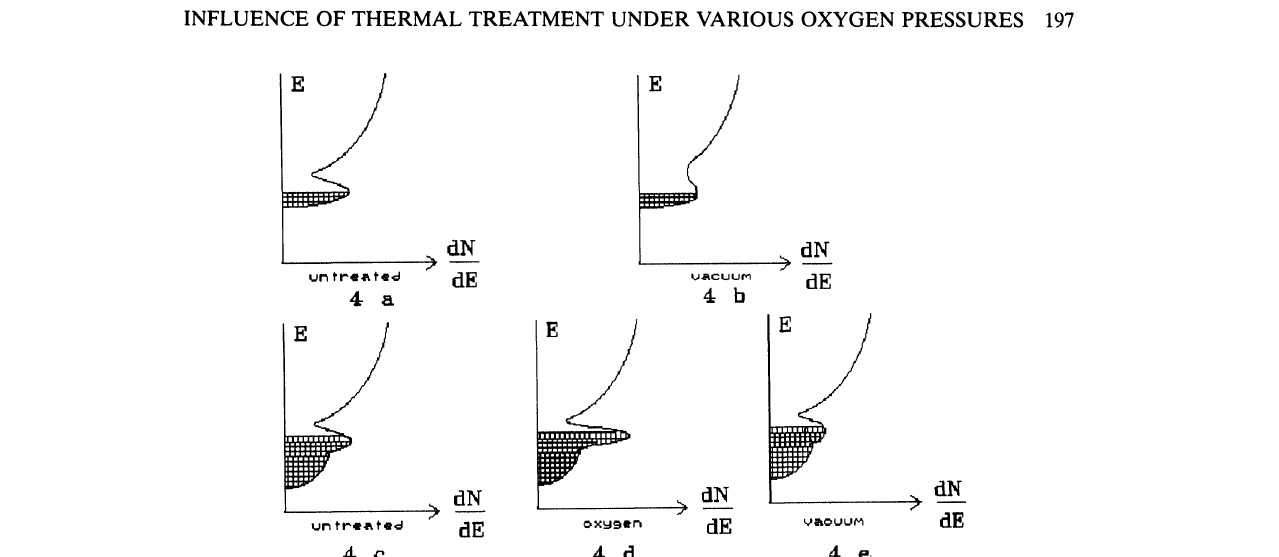
FIGURE 4 Schematic energy band diagrams for In203 and Sn doped In203 untreaded, treated under vacuum or under oxygen pressure; 4a, 4b" pure In:O3; 4c, 4d, 4e: Sn doped In:O3.